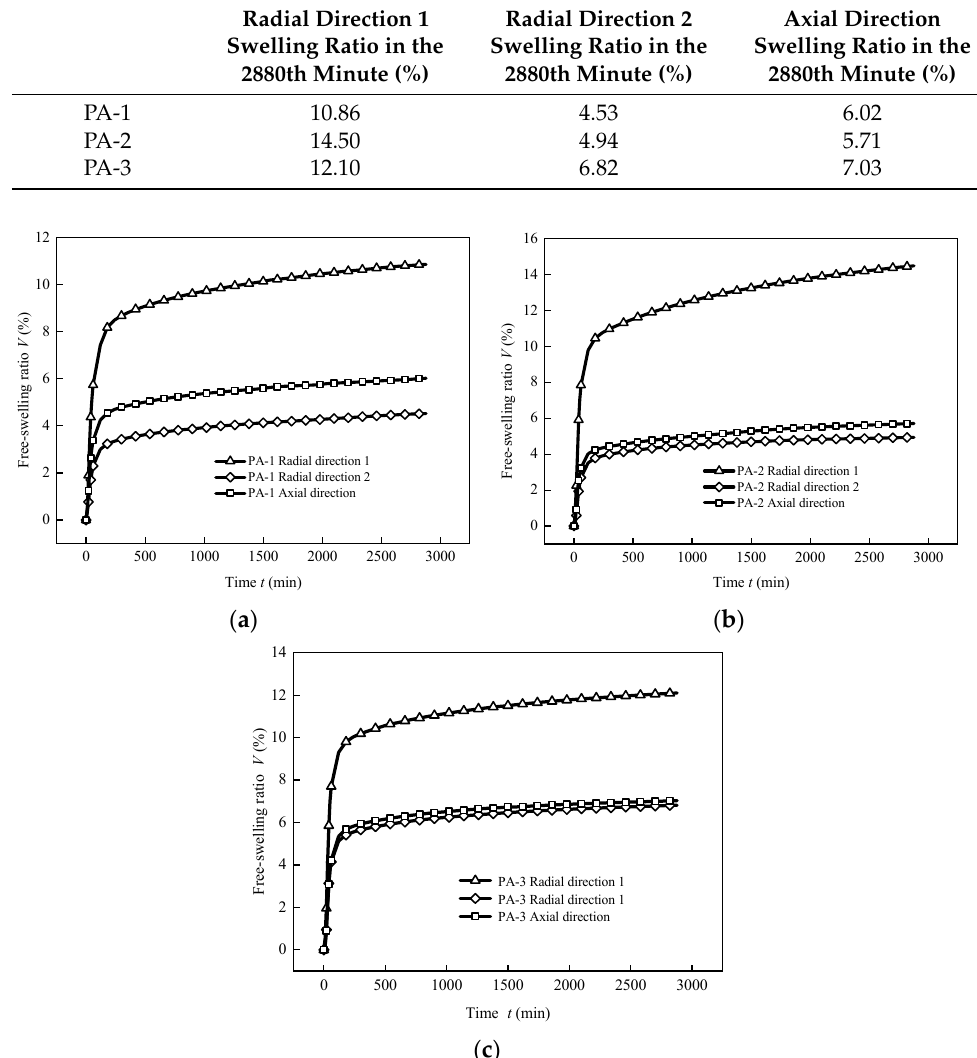
Table 2. Free-swelling ratio.